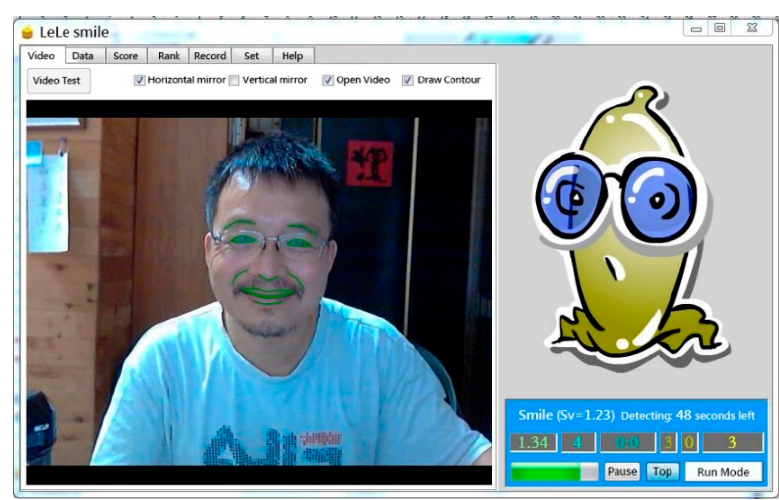
Figure 4. Happiness determination process.